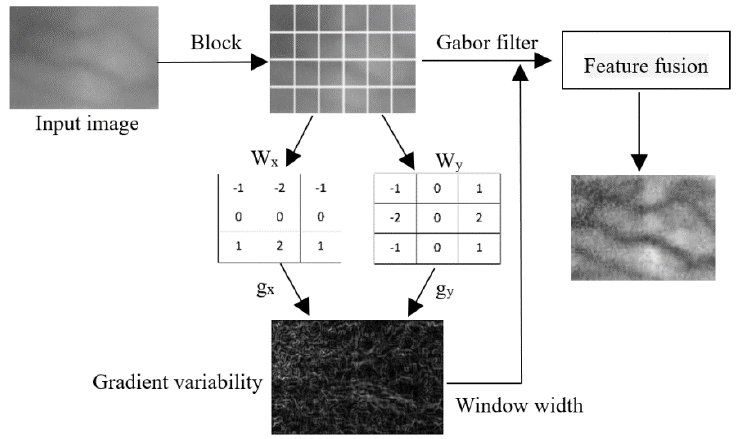
Figure 2. Adaptive feature extraction process.